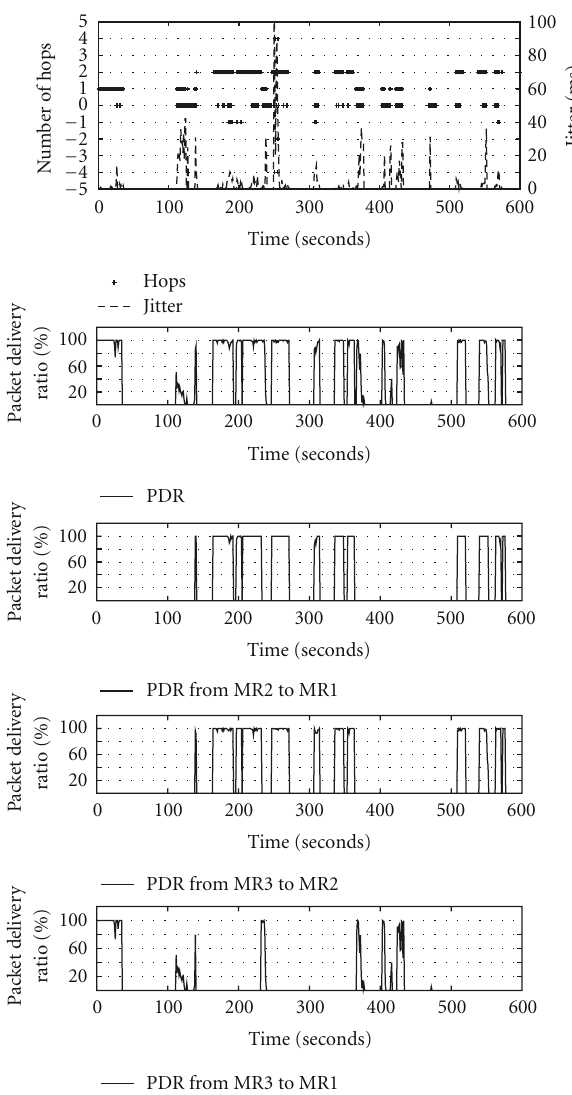
Figure 11: UDP performances over a multihop VANET of three cars moving in an urban